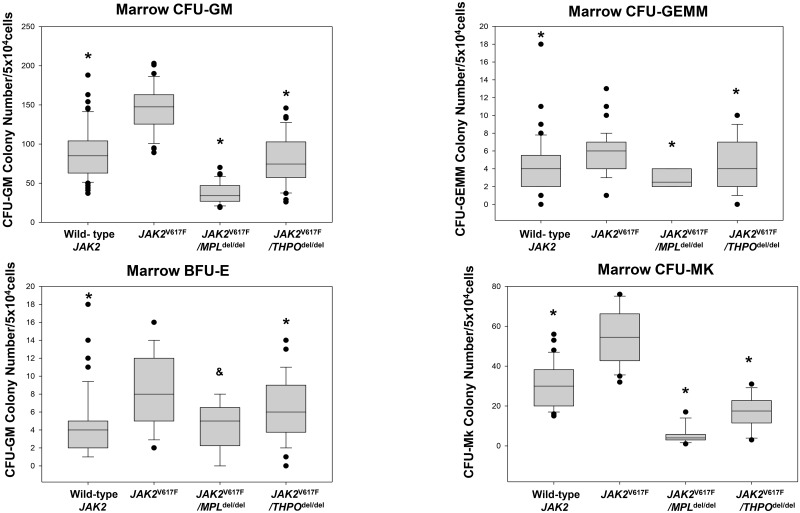
MPLdel and THPOdel genotypes mitigate marrow HPC colony formation in a JAK2V617F transgenic mouse model of PV.(A) In vitro colony formation by marrow CFU-GM from JAK2V617F transgenic mice (n = 10) was increased compared to wild-type mice (n = 10) (*P < 0.001), but was reduced below the wild-type level in JAK2V617F/MPLdel/del (n = 6) transgenic mice (*P < 0.001). By contrast, CFU-GM colony formation by JAK2V617F/THPOdel/del transgenic mice (n = 6) was similar to wild-type mice. (B) In vitro colony formation by marrow CFU-GEMM from JAK2V617F transgenic mice was increased compared to wild-type mice and JAK2V617F/MPLdel/del and JAK2V617F/THPOdel/del transgenic mice (*P < 0.001). (C) In vitro colony formation by marrow BFU-E from JAK2V617F transgenic mice was increased compared to wild-type mice and JAK2V617F/MPLdel/del and JAK2V617F/THPOdel/del transgenic mice (*P < 0.001). (D) In vitro colony formation by marrow CFU-Mk from JAK2V617F transgenic mice was increased compared to wild-type mice and JAK2V617F/MPLdel/del and JAK2V617F/THPOdel/del transgenic mice (*P < 0.001). Importantly, HPC colony formation also provides insight into the contribution of JAK2V617F compared to THPO in this transgenic mouse model based on HPC colony formation in the absence of THPO. This was best observed with CFU-GM and CFU-Mk, for which the increments induced by JAK2V617F were the most robust: for CFU-GM, the increment induced by JAK2V617F was abolished by the absence of THPO, while for CFU-Mk, colony formation by JAK2V617F in the absence of THPO was 50% of wild-type. The horizontal lines of the boxes indicate the 25th percentile, the median and the 75th percentile respectively and the error bars indicate the 10th and 90th percentiles. *P <0.001; §P<0.02. The number (n) of mice of each genotype used in all the experiments is in parentheses.